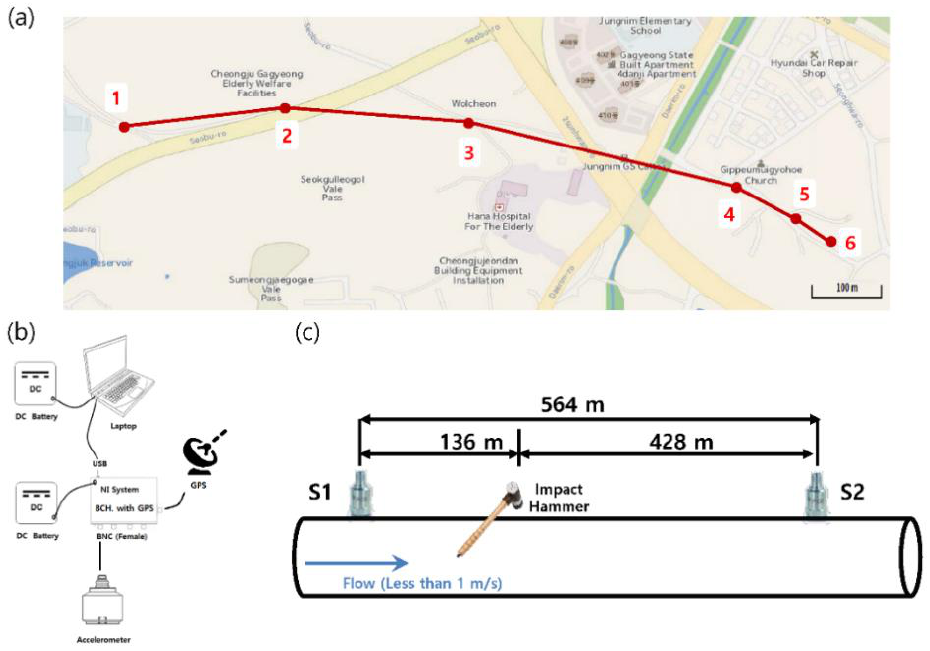
Figure 6. Schematics for experiments; ( a ) pipeline layout on map, ( b ) measurement setup at each sensing point, ( c ) pipeline and locations of sensors and impact hammer (the sensors and hammer are exaggerated).